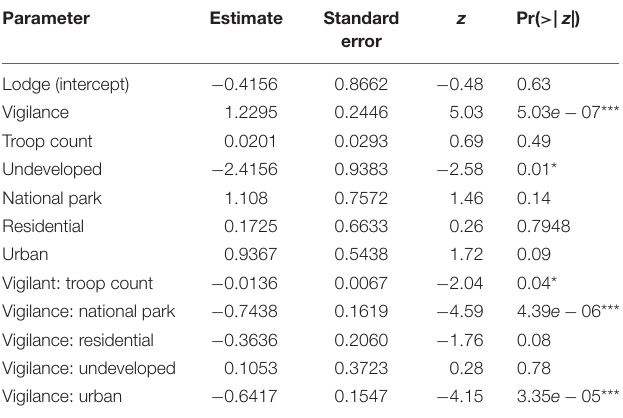
lowest level of olfactory communication by land type ( Table 2